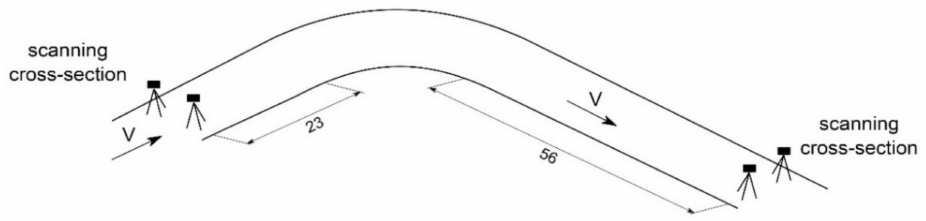
Figure 3. Diagram of arrangement of scanning